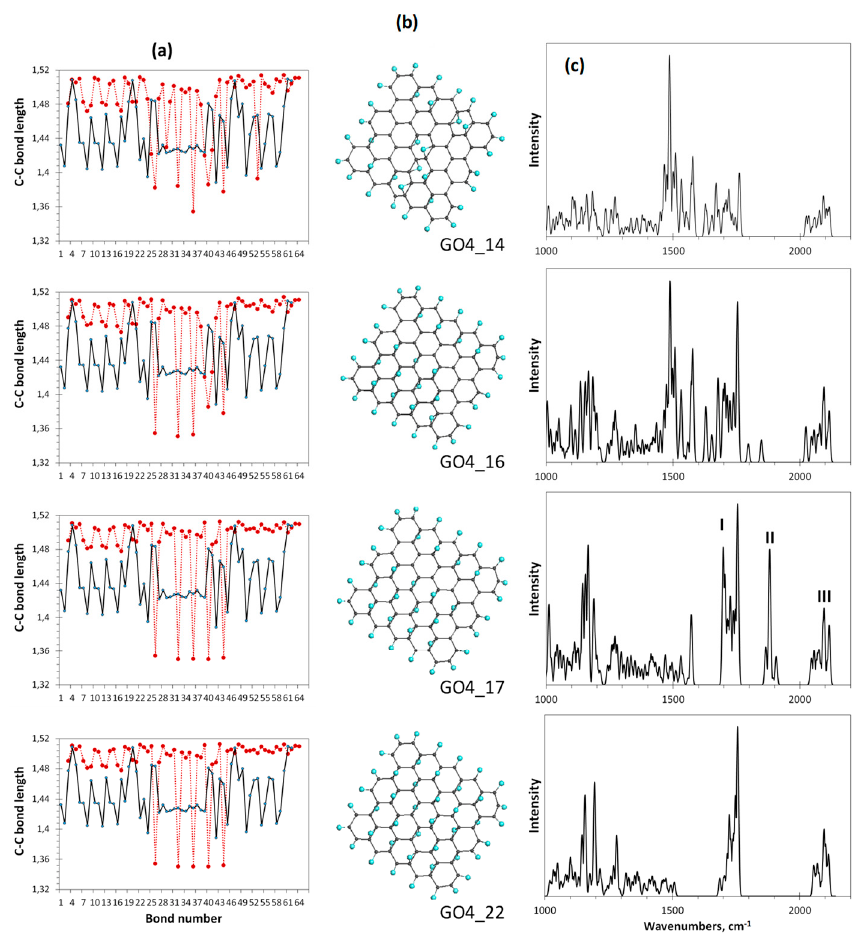
Figure 8. Monitoring of the sp 2 - to -sp 3 C-C bond structure transformation the at final steps of the oxidation of basal-plane carbon atoms of GO4. ( a ). TD’s C-C bond length distributions (reference and step current presented with solid black and dotted red plottings, respectively). ( b ). TD’s equilibrium structures. ( c ). TD’s Raman spectra. UHF AM1 calculations.